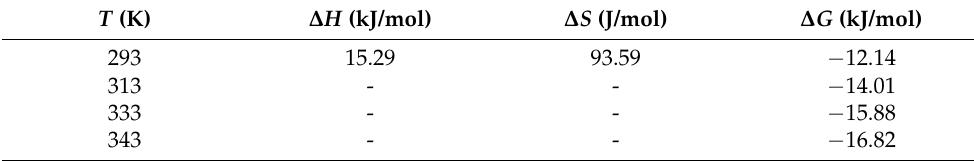
Table 4. Thermodynamic parameters for the adsorption of SDS by modified cellulose.